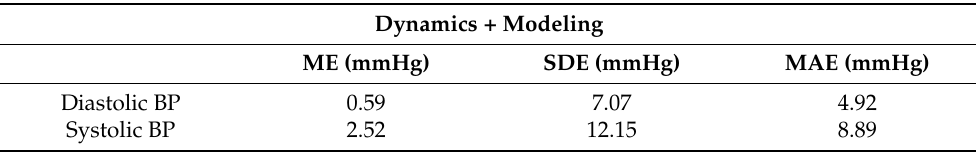
Figure 6. Sensitivity ranking for the SBP model. S (cid:2919) and S (cid:2904)(cid:2919) show the results for first-order sensitiv- ity and total effect sensitivity, respectively. Red, blue and green bars correspond to K (cid:2912) , K (cid:2913) and K (cid:2911) parameters respectively.